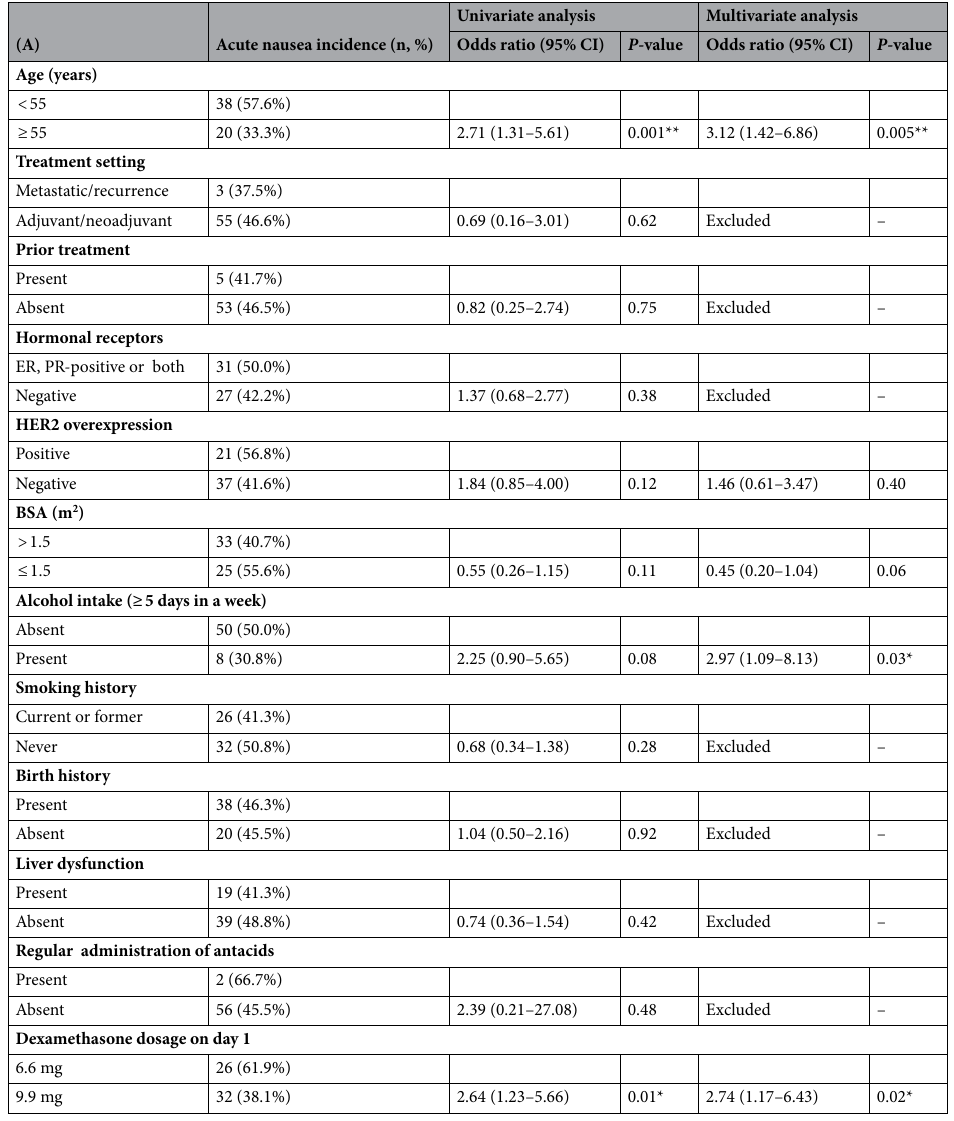
Table 2. Univariate and multivariate analyses of the risk factors associated with the frequency of nausea in the acute phase. * P < 0.05, ** P < 0.01. CI confidential interval, ER estrogen receptor, PR progesterone receptor, HER2 human epidermal growth factor receptor 2, BSA body surface area. Liver dysfunction: grade 1 or higher aspartate aminotransferase, alanine aminotransferase, γ-glutamyltransferase, total bilirubin elevation. Antacids include proton pump inhibitors and histamine type 2 receptor